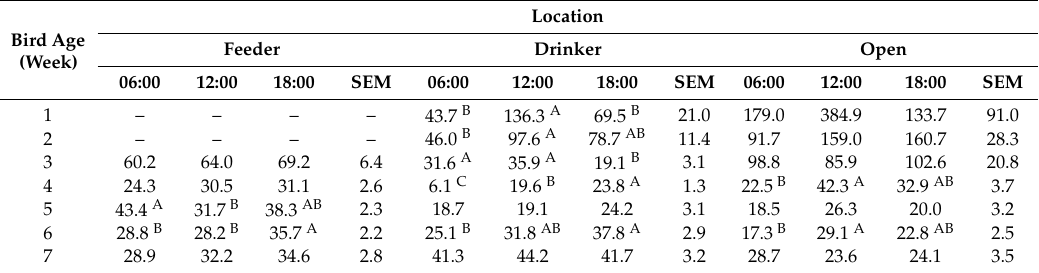
SEM: Pooled standard error mean for main e ff ects of time periods at each location. A,B,C Means in the same row with di ff erent superscripts under the same location category are di ff erent ( p < 0.05). Data with a time interval of